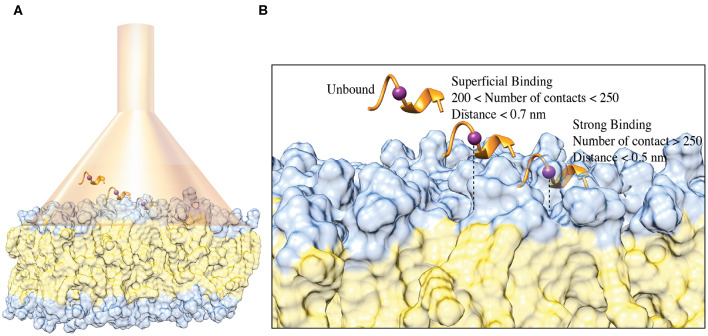
(A) Schematic representation of the FMD setting. C8 peptide is represented in the orange ribbon, while the purple spheres represent the Cα atom of Val5. The membrane is represented as a molecular surface where the polar heads and the aliphatic chains of the phospholipids are colored in light blue and in lithe yellow, respectively. (B) Schematic representation of the binding states of the C8 peptide with the membrane. The peptide and the membrane are represented as in (A). The distance between Cα atom of the Val5, and the polar heads of the phospholipids is reported as a dashed line.